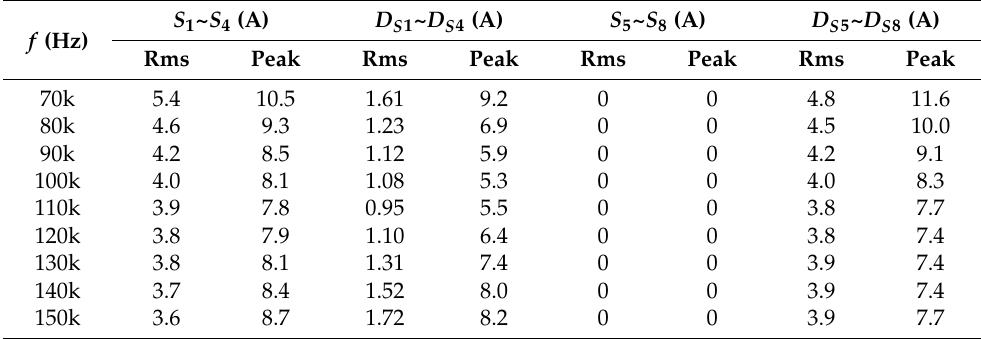
Table 4. Current stress of the power switches and diodes for the primary and secondary